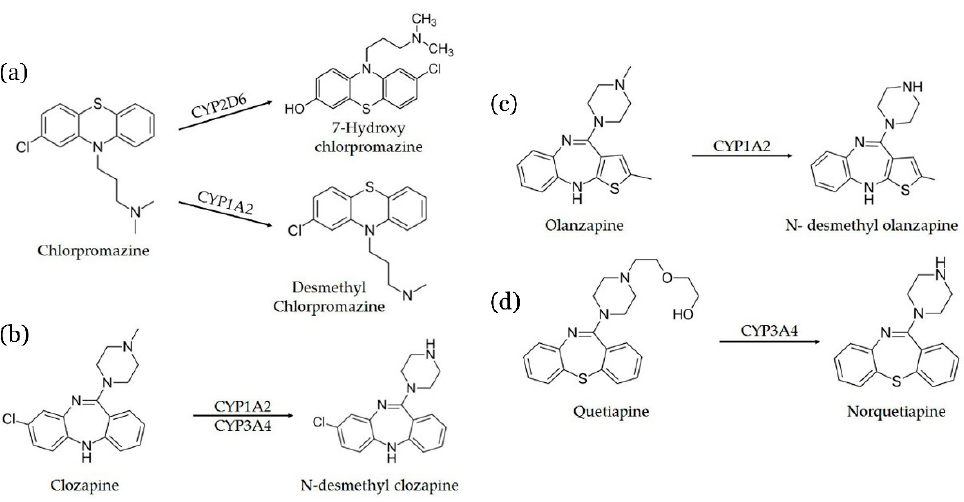
Figure 1. Biotransformation pathways of ( a ) Chlorpromazine, ( b ) Clozapine, ( c ) Olanzapine, and ( d ) Quetiapine. CYP = cytochrome P450 complex. CYP1A2, CYP2D6, and CYP3A4 are isoenzymes of cytochrome P450 complex.